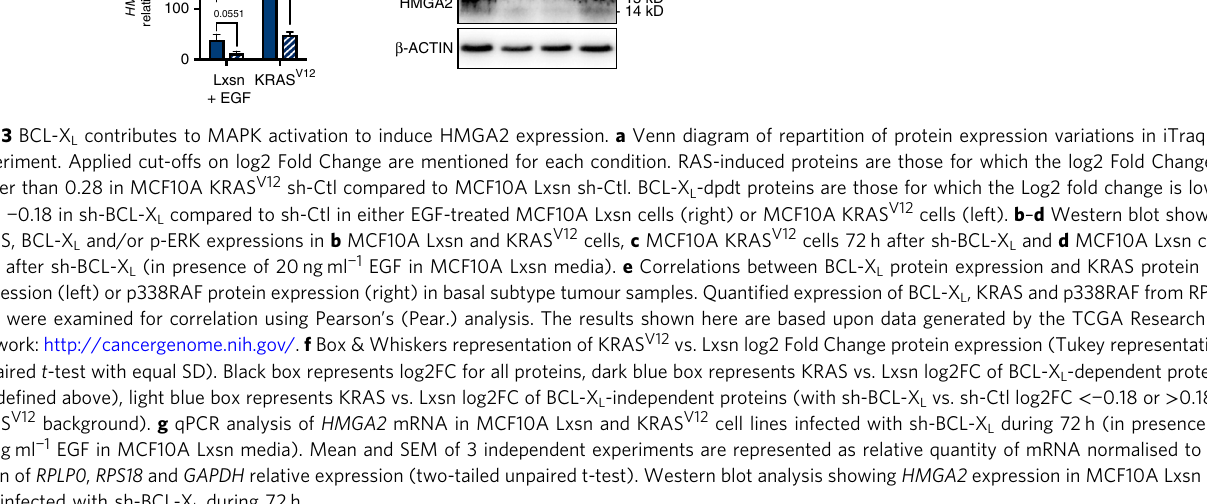
itself. Down-regulation of KRAS upon BCL-X L depletion was con fi rmed in MCF10A KRAS V12 cells by western blot analysis (Fig. 3b) and was con fi rmed in MCF10A KRAS V12 cells in which BCL2L1 was knocked out by CRISPR/Cas9 (Supplementary Fig. 5a). We assume this re fl ects a positive effect of BCL-X L on KRAS protein turnover, since sh-BCL-X L had no detectable